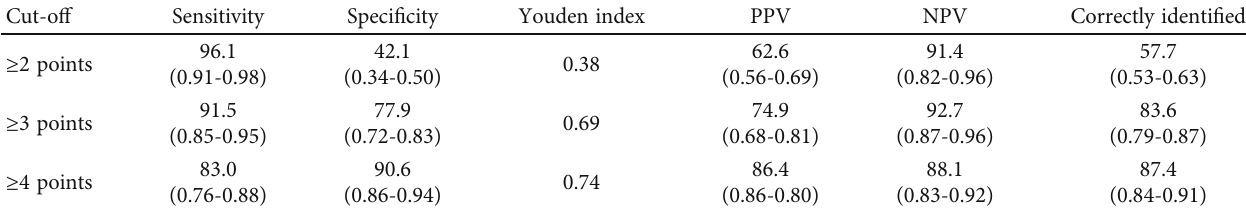
Table 4: Psychometric properties of AD8-P at di ff erent cut-o ff points.